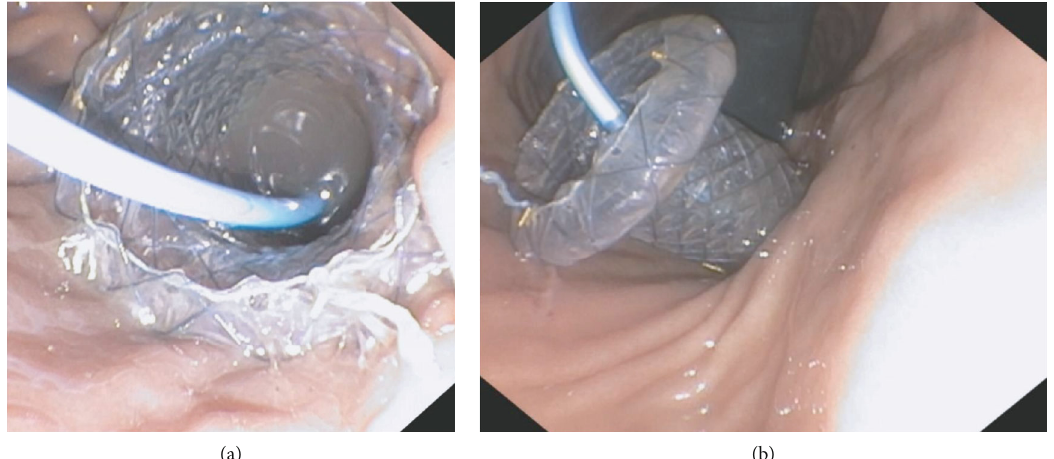
Figure 6: (a, b) Active transmural drainage. Transmurally/transgastrically placed LAMS in a patient undergoing endoscopic drainage of a